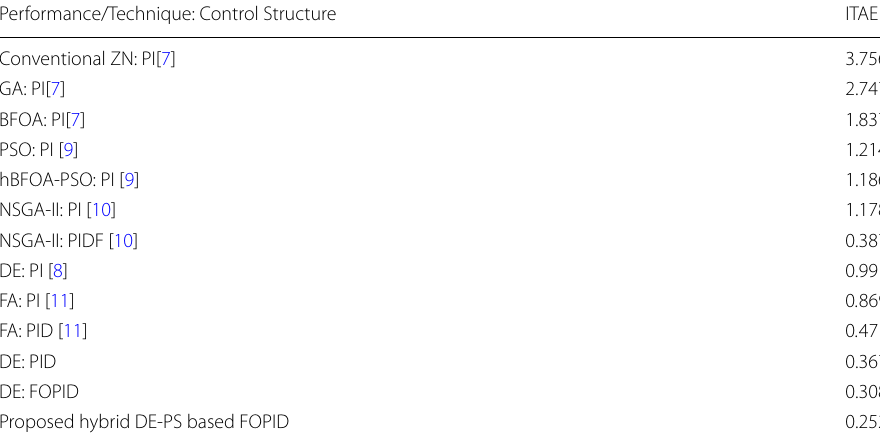
Table 8 Comparison of various AGC approaches for a 2-area system Performance/Technique: Control